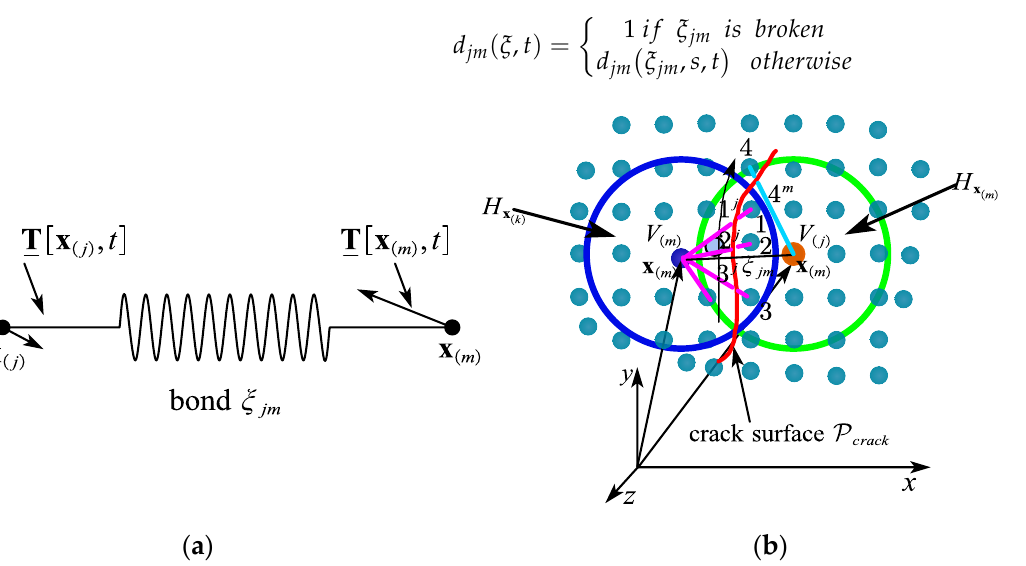
Figure 6. The progressive failure leading to crack surface. ( a ) The force on peridynamic bond. ( b ) Progressive failure of peridynamic bond.